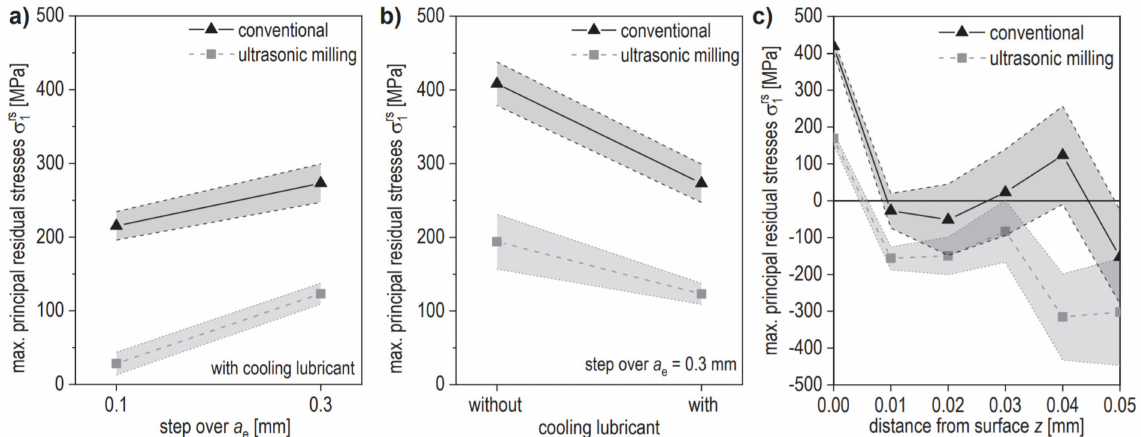
Figure 26. Maximum principal residual stresses vs. step over a e and the application of ultrasonic assistance ( a ) and vs. the application of cooling lubricant and ultrasonic assistance ( b ), and the maximum principal residual stress profile in the direction of the specimen thickness after finishing milling with and without ultrasonic assistance ( c ) [112].